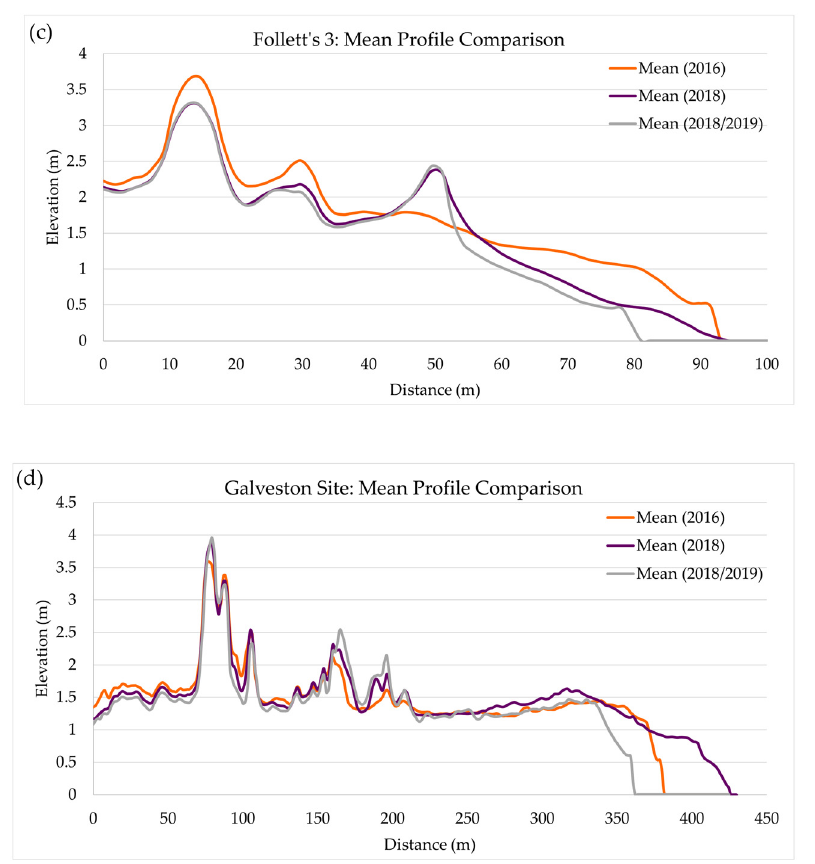
Figure 14. Multiyear profile analyses to examine temporal variation from 2016 to 2019. ( a ) Follett’s Site 1 Profile 2; ( b ) Follett’s 2 Profile 4; ( c ) Follett’s Site 3 Profile 2; ( d ) Galveston Site Profile